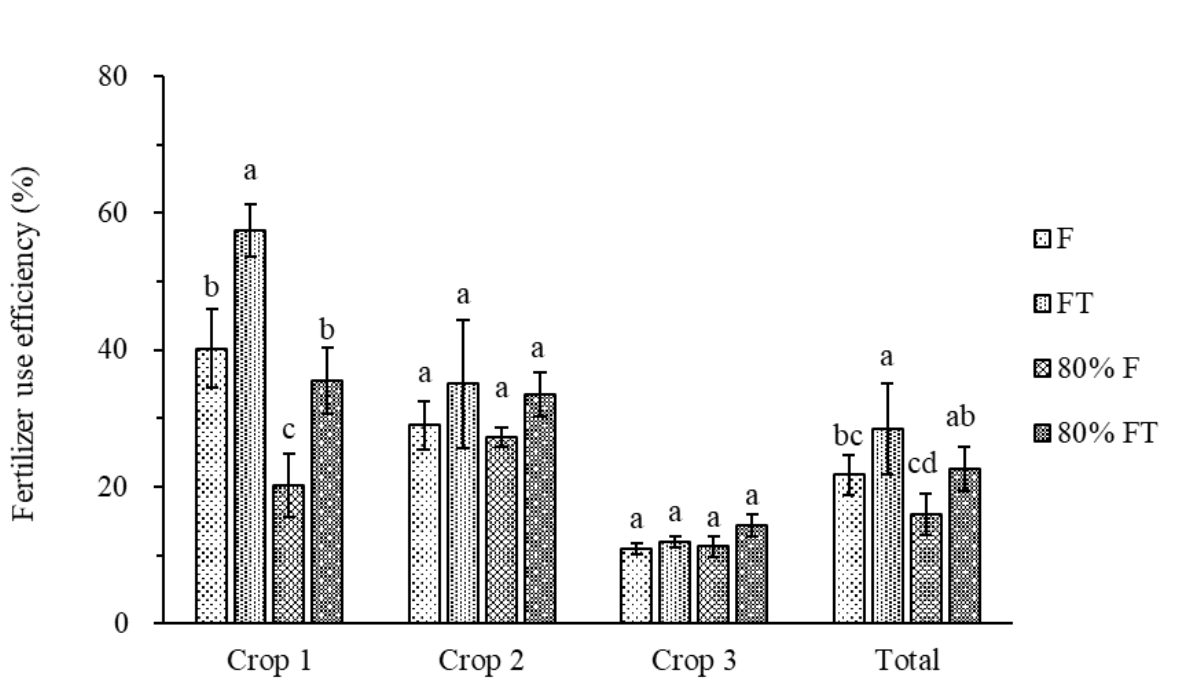
Figure 6. Effects of the preparation on fertiliser use efficiency. Values were expressed as means (n = 4) ± SE. Different letters within the same crop indicate significance at the 5% level.